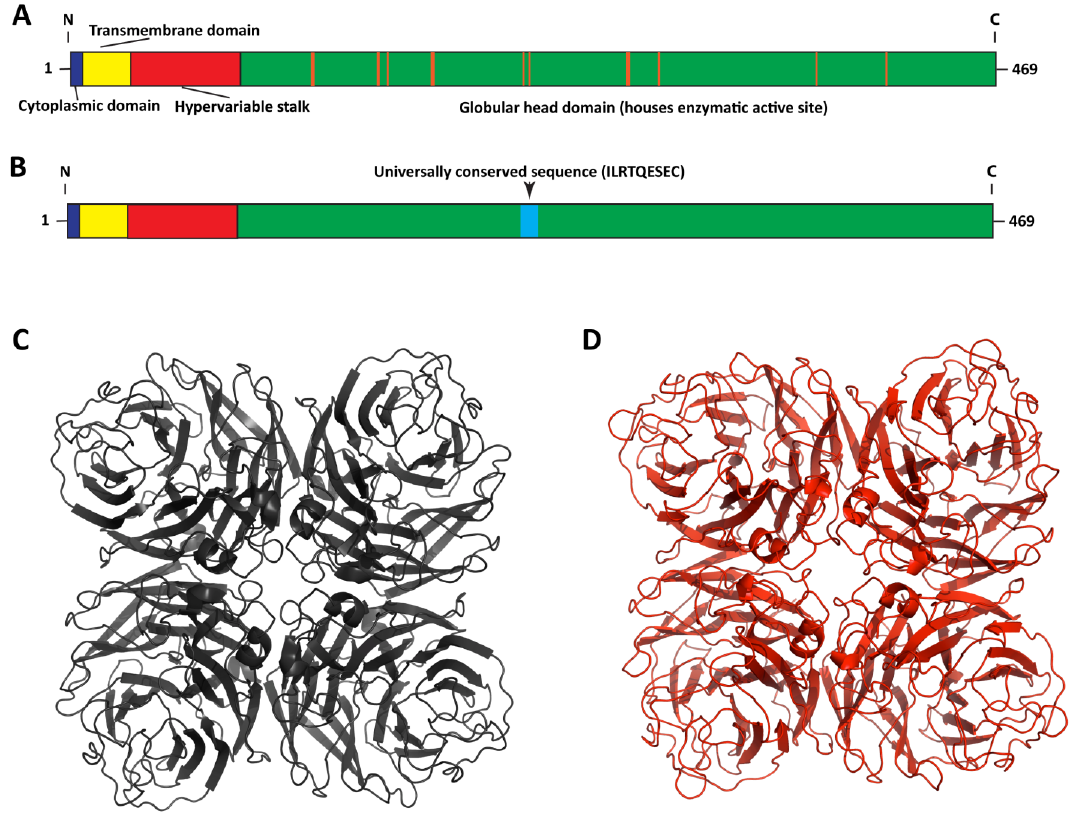
Figure 2. The 3D structure of Influenza A Virus NA is highly conserved. ( A ) Schematic of the NA protein (to scale) showing the cytoplasmic, transmembrane, hypervariable stalk, and globular head domains, using amino acid residue numbering from the NA of A/Brevig Mission/1/1918 (H1N1). Orange lines represent the positions of active site residues that form contacts with zanamivir (as determined from the crystal structure of the active site shown in panel 2F). ( B ) Highlighted in light blue is the position of the 9-residue sequence ILRTQESEC, which is universally conserved among all known NA subtypes (again, N1 numbering from A/Brevig Mission/1/1918) [39]. NA displays a remarkably conserved 6-bladed propeller structure. Each blade is made up of four anti-parallel beta sheets stabilized by disulfide bonds and connected by loops of varying length. ( C ) 3D crystal structure of the globular head domain of the NA from A/Brevig Mission/1/1918 (H1N1) (PDB ID: 3B7E), shown as a tetramer. ( D ) 3D crystal structure of the globular head domain of the NA from A/Tanzania/205/2010 (H3N2) (PDB ID: 4GZQ) [40], shown as a tetramer. ( E ) Despite the amino acid sequence differences across NA subtypes, the 3D structure tends to be conserved, as evidenced by the aligned structural overlay of the N1 and N2 from previous figure panels, 2C and 2D. There is one enzymatic active site per NA monomer, although NA is thought to be only enzymatically active as a tetramer. ( F ) Zoomed-in view of one of the four identical active sites of the NA tetramer (A/Brevig Mission/1/1918) complexed with zanamivir (the approximate corresponding location on the 3D structure in panel 2E is indicated by a green box). The electron density of NA is shown as a solid red contour map ( top panel). Residues that make chemical contacts with zanamivir in the crystal structure are shown as color-coded, labeled lines ( bottom